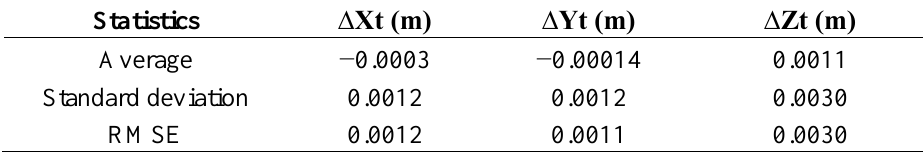
Table 7. Statistics of the discrepancies in checkpoint after bundle adjustment.